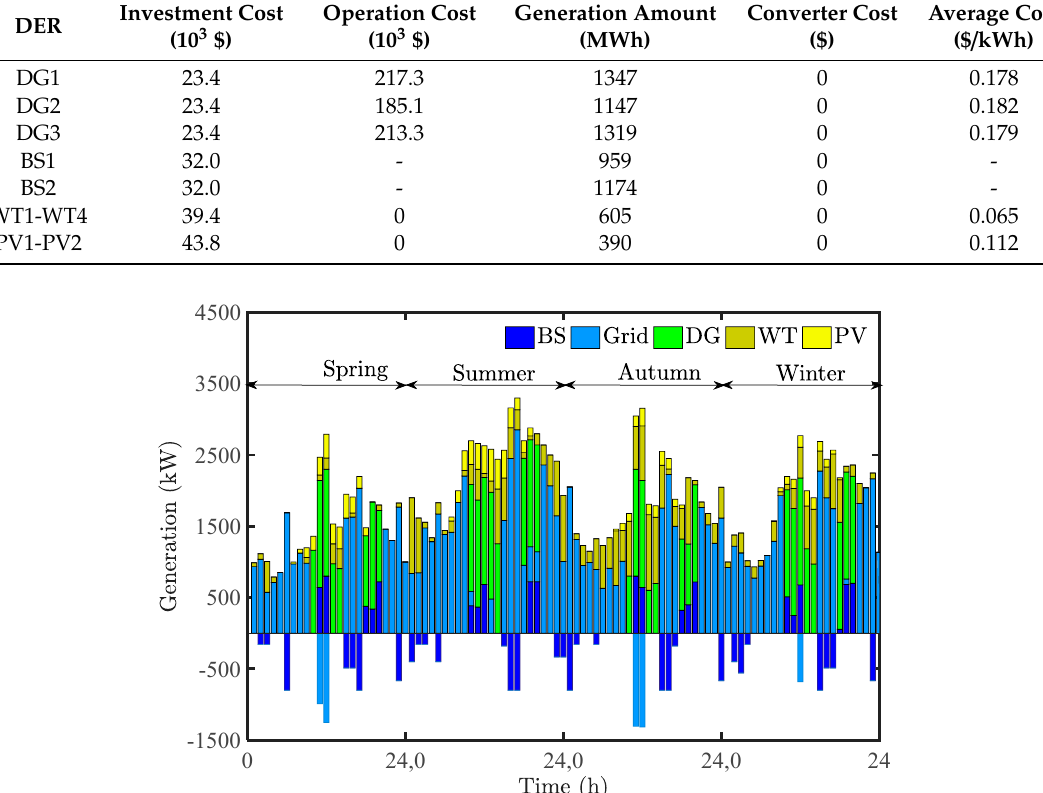
Figure 7. The generation schedule of DERs in the MG in the typical days.